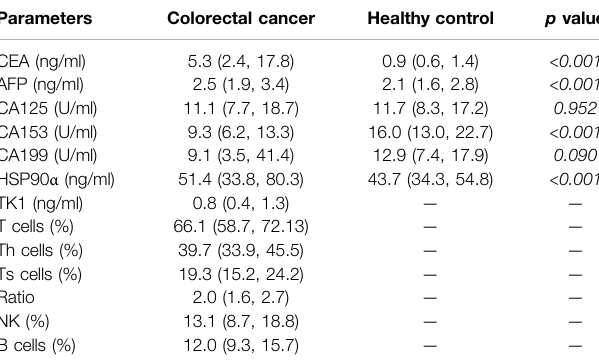
TABLE 1 | Basic pro fi le of tumor markers and immune cells in patients with colorectal cancer.